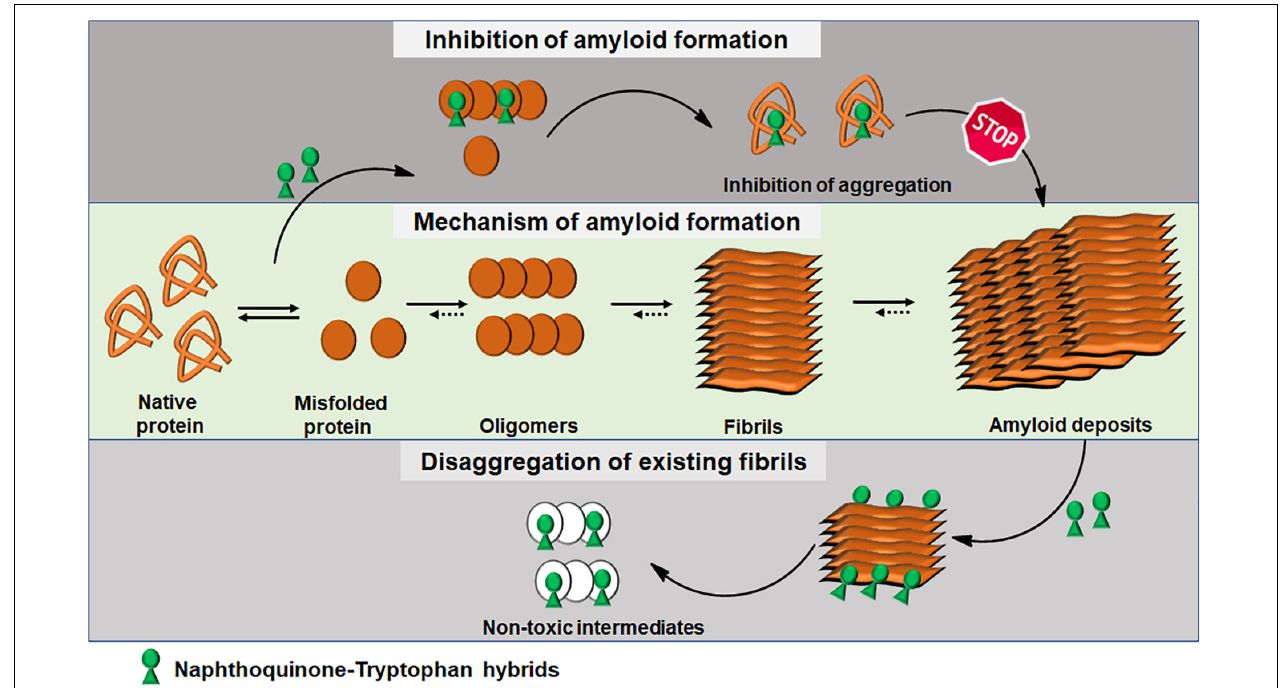
FIGURE 3 | Schematics of amyloid aggregation and its inhibition/disaggregation by Naphthoquinone-Tryptophan hybrid